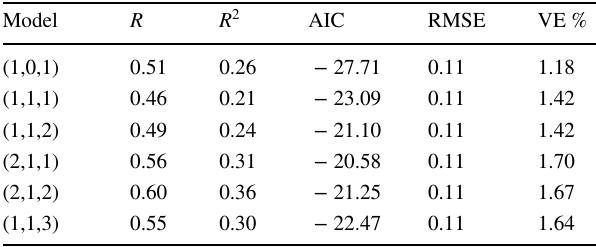
Table 5 The consequences of SO 42− group, order (1, 1)